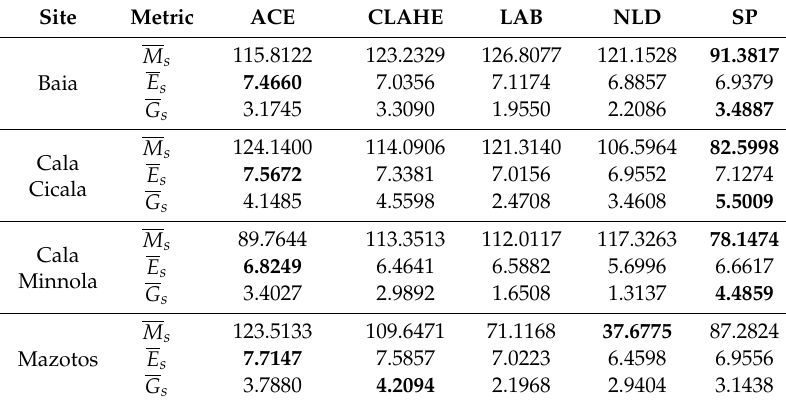
Table 2. Summary table of the average metrics calculated for each